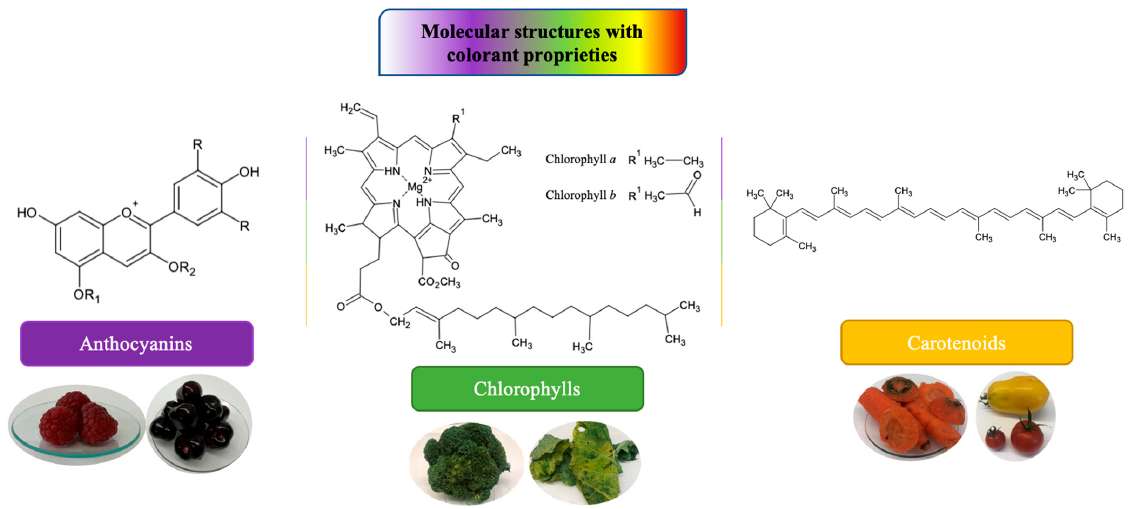
Figure 2. Molecular structures of representative food colorants from natural sources .